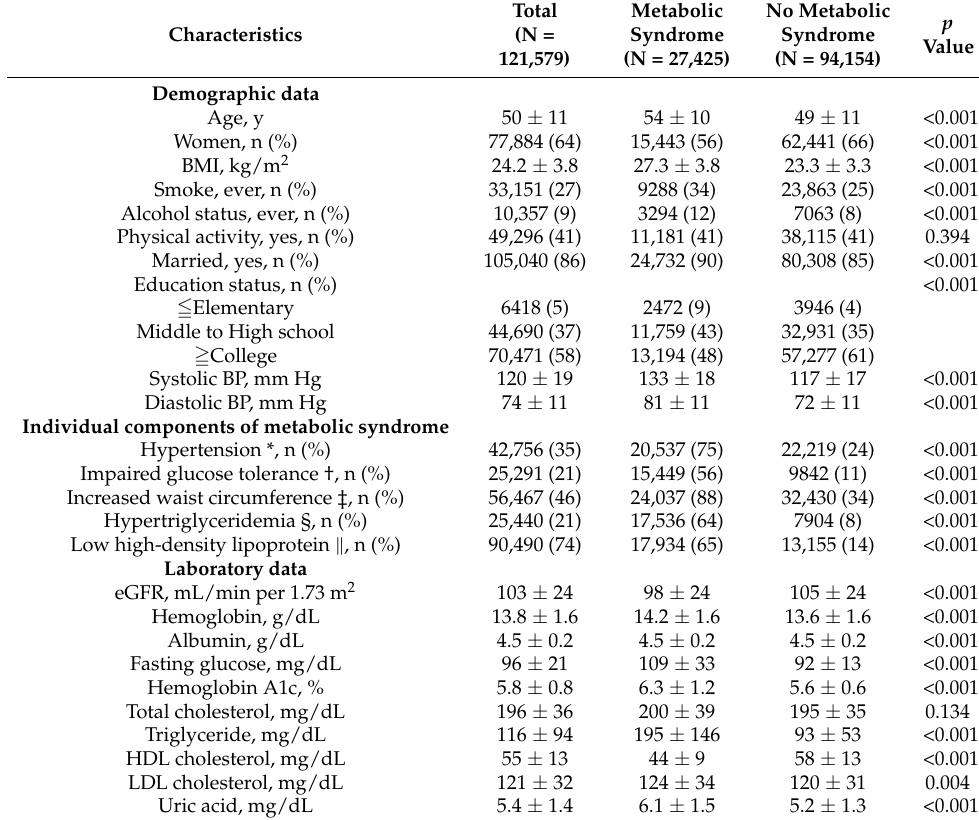
Table 1. Clinical profiles of the study participants classified by the presence of metabolic